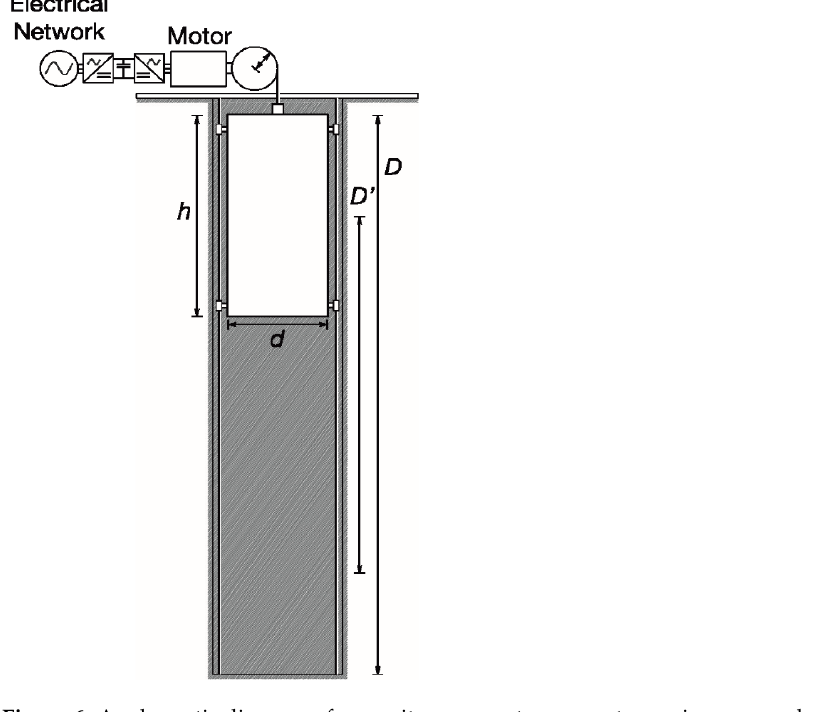
Figure 6. A schematic diagram of a gravity energy storage system using suspended weight [57].